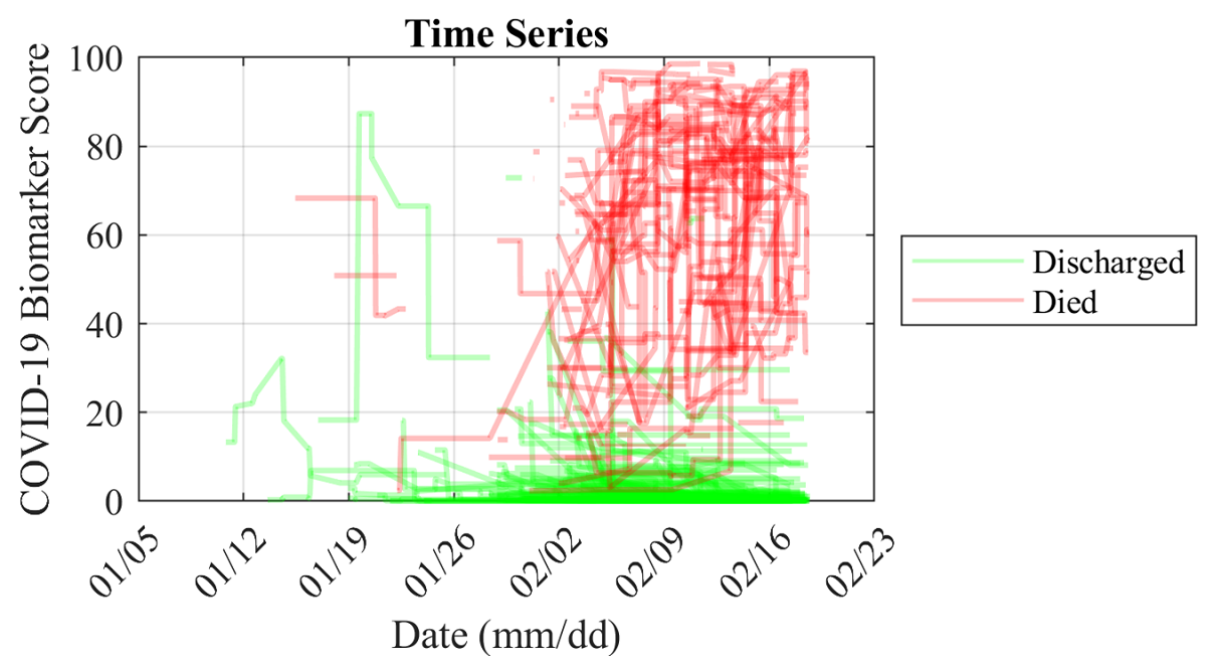
Figure 5. Spaghetti plot of longitudinal COVID-19 Biomarker Scores for patients in the external validation set from Tongji Hospital [21] between January 10 and February 18, 2020. These data represent individual patients’ scores over a median (IQR) of 12.5 (8–17.5) days between admission and outcomes of discharged or deceased. The first scores available after admission were significantly higher in those that died vs those that were discharged (AUC 0.97, cutoff score of 19), and over time patients who were discharged had an average decrease in score (-4.7) while those that died had an average increase in score